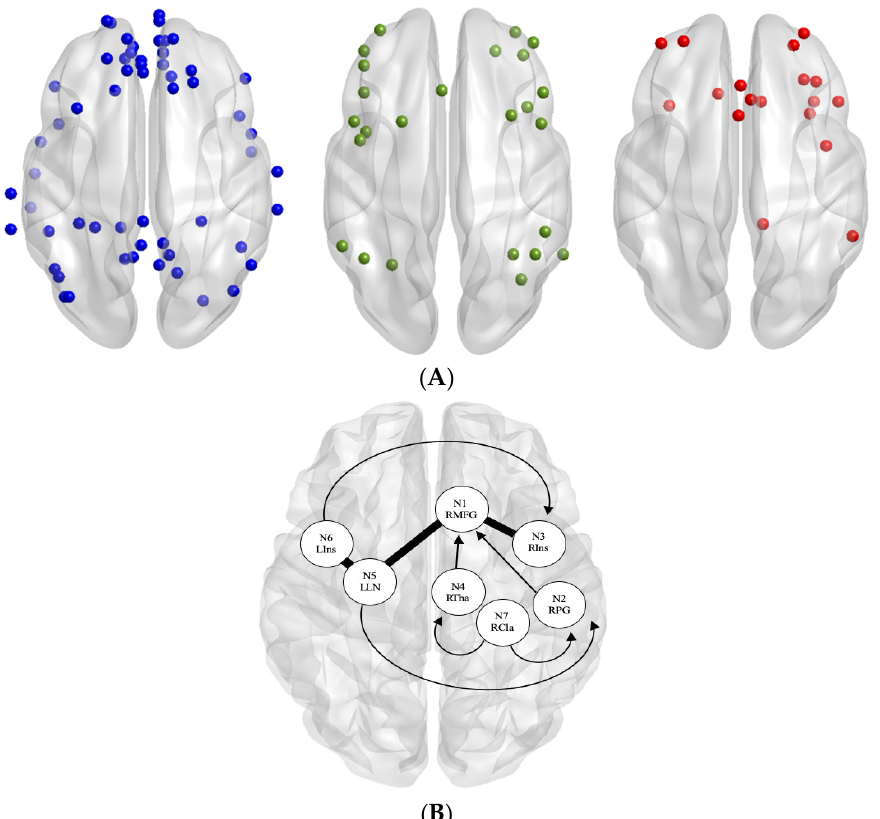
Figure 1. ( A ) Original nodes used in each network: ( blue ) default mode network (DMN), ( green ) frontoparietal network (FPN), and ( red ) salience network (SN). ( B ) Pain nodes used, derived from chronic pain functional meta-analytic connectivity modelling (MACM) results [35]. Regions of interest (ROI) labels: N1 RMFG = right medial frontal gyrus, N2 RPG = right postcentral gyrus, N3 RIns = right insula, N4 RTha = right thalamus, N5 LLN = left lentiform nucleus, N6 LIns = left insula, and N7 RCla = right claustrum. Arrows denote one-way connections projecting from the starting node. Thick non-arrows denote two-way connections between nodes.